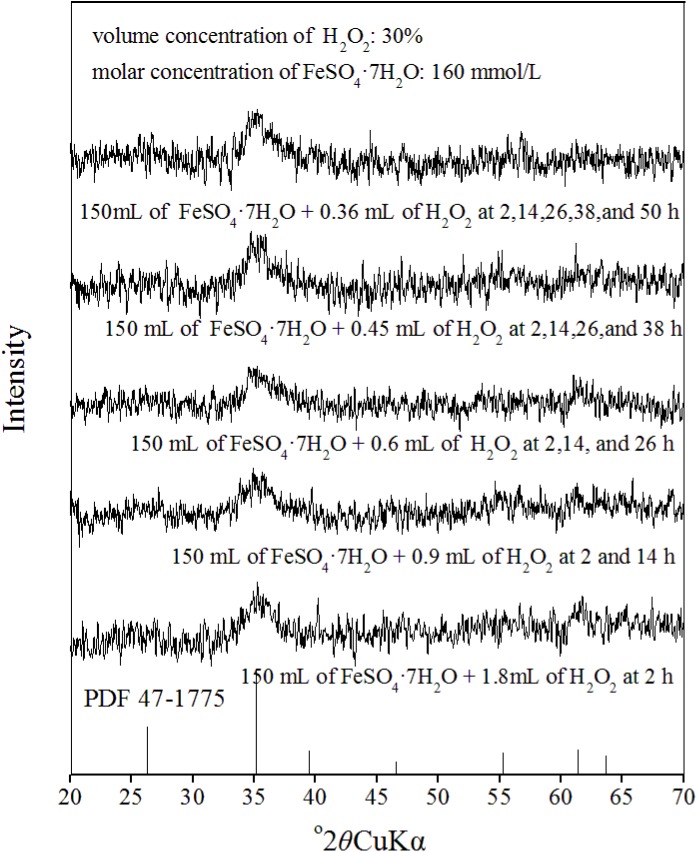
X-ray diffraction (XRD) patterns of iron precipitates harvested from ferrous ions oxidation systems with H2O2 adding FeSO4·7H2O solution at different rates